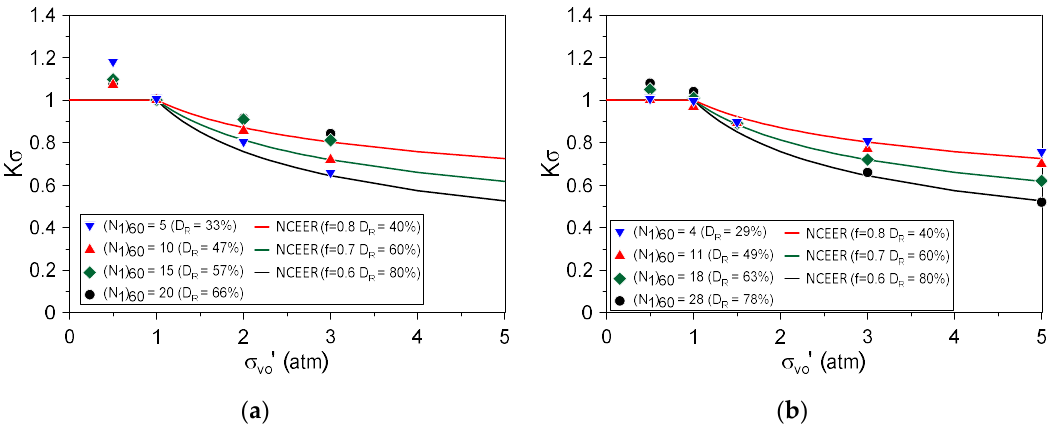
Figure 7. Overburden stress effects on the CRR and comparison with curves in the NCEER procedure. ( a ) Finn model; ( b ) UBCSAND model (modified from Beaty and Byrne, 2011) [19].